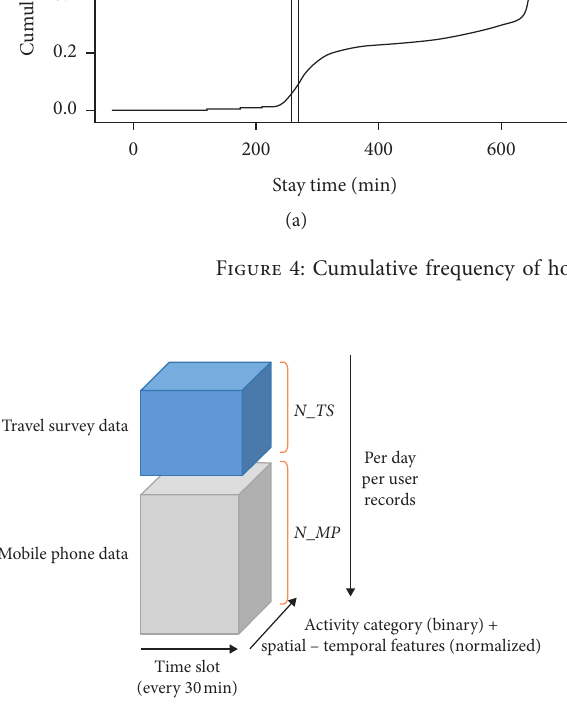
Figure 5: Construction of user-activity-context tensor.